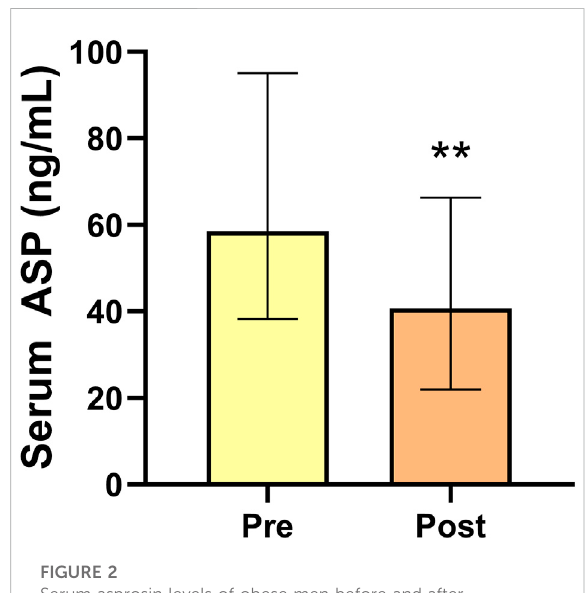
FIGURE 1 Serum asprosin level in the normal and obesity groups. Data are presented as medians (Me) and quartiles (Q1, Q3); Mann – Whitney test ** p < 0.01 for difference from the normal group.